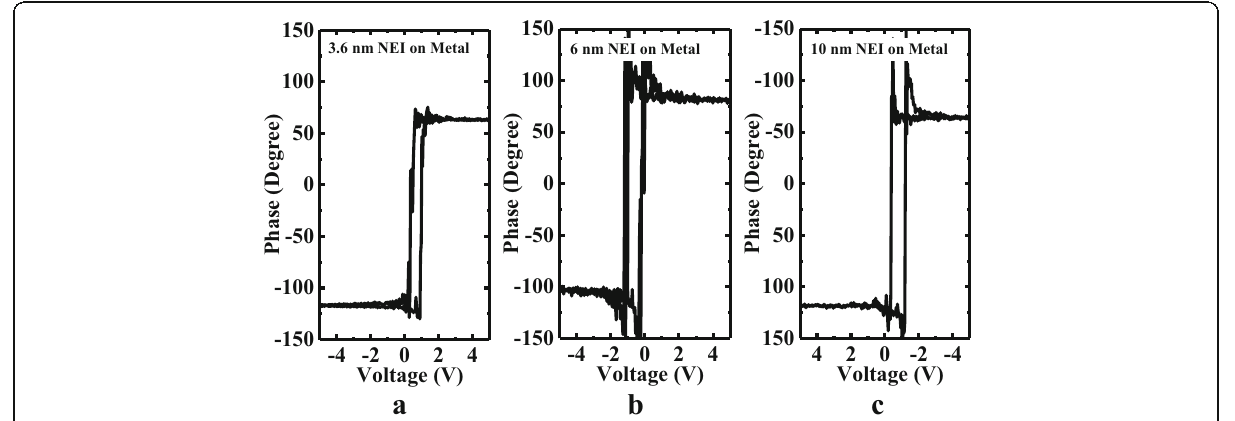
Fig. 6 a – c Phase change characteristics of 3.6, 6, and 10 nm NEI on TaN, respectively. It is observed that opposite polarity can be written onto the surface of the NEI